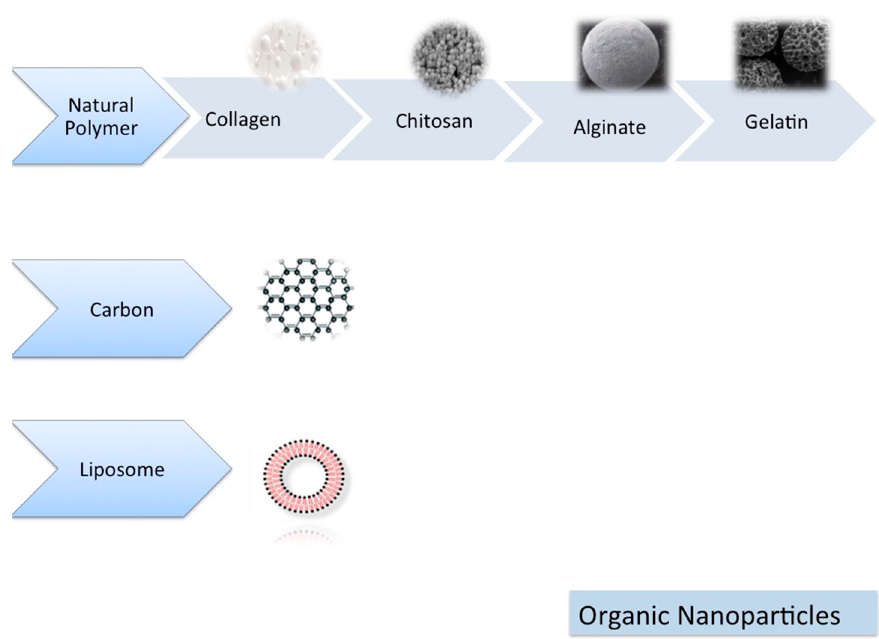
Figure 2. Organic nanomaterials.